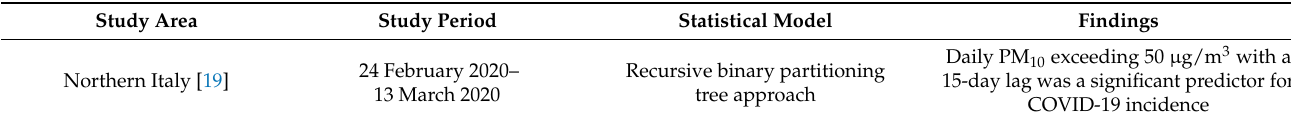
Table 1. Literature Review on Air Pollution and